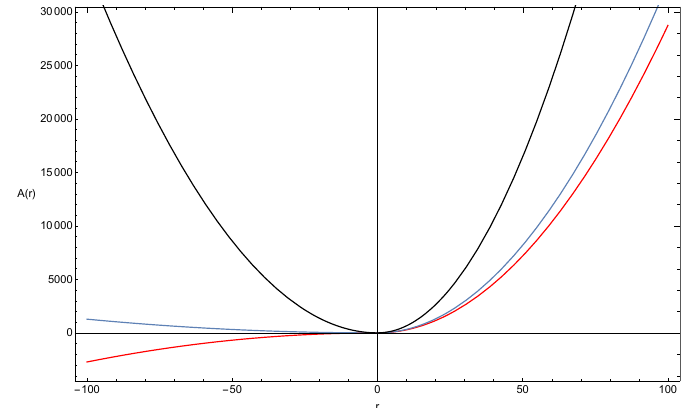
Figure 1. Plots of the coefficient A ( r ) versus r for different values of A 0 . The red, blue and black solid lines represent A 0 = 1.3, A 0 = 1.7 and A 0 = 5 respectively. We have chosen the parameters a = 0.001 and b = r 0 = 1 and A 0 = 1. Negative values of r are also plotted which represent the other